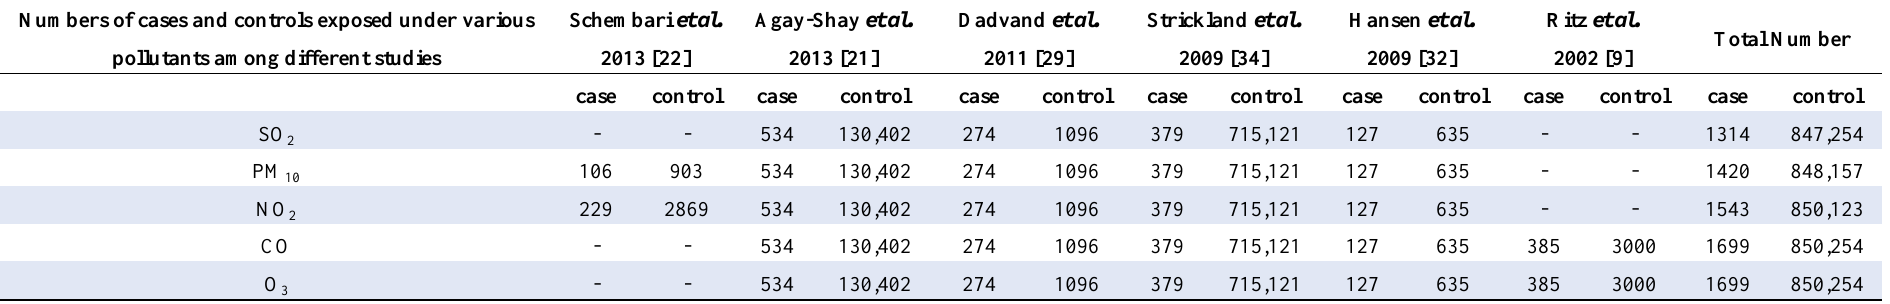
Table 4. Numbers of atrial septal defects cases and number of controls in studies included in the meta analysis for 5 pollutants: SO NO , CO, O 2